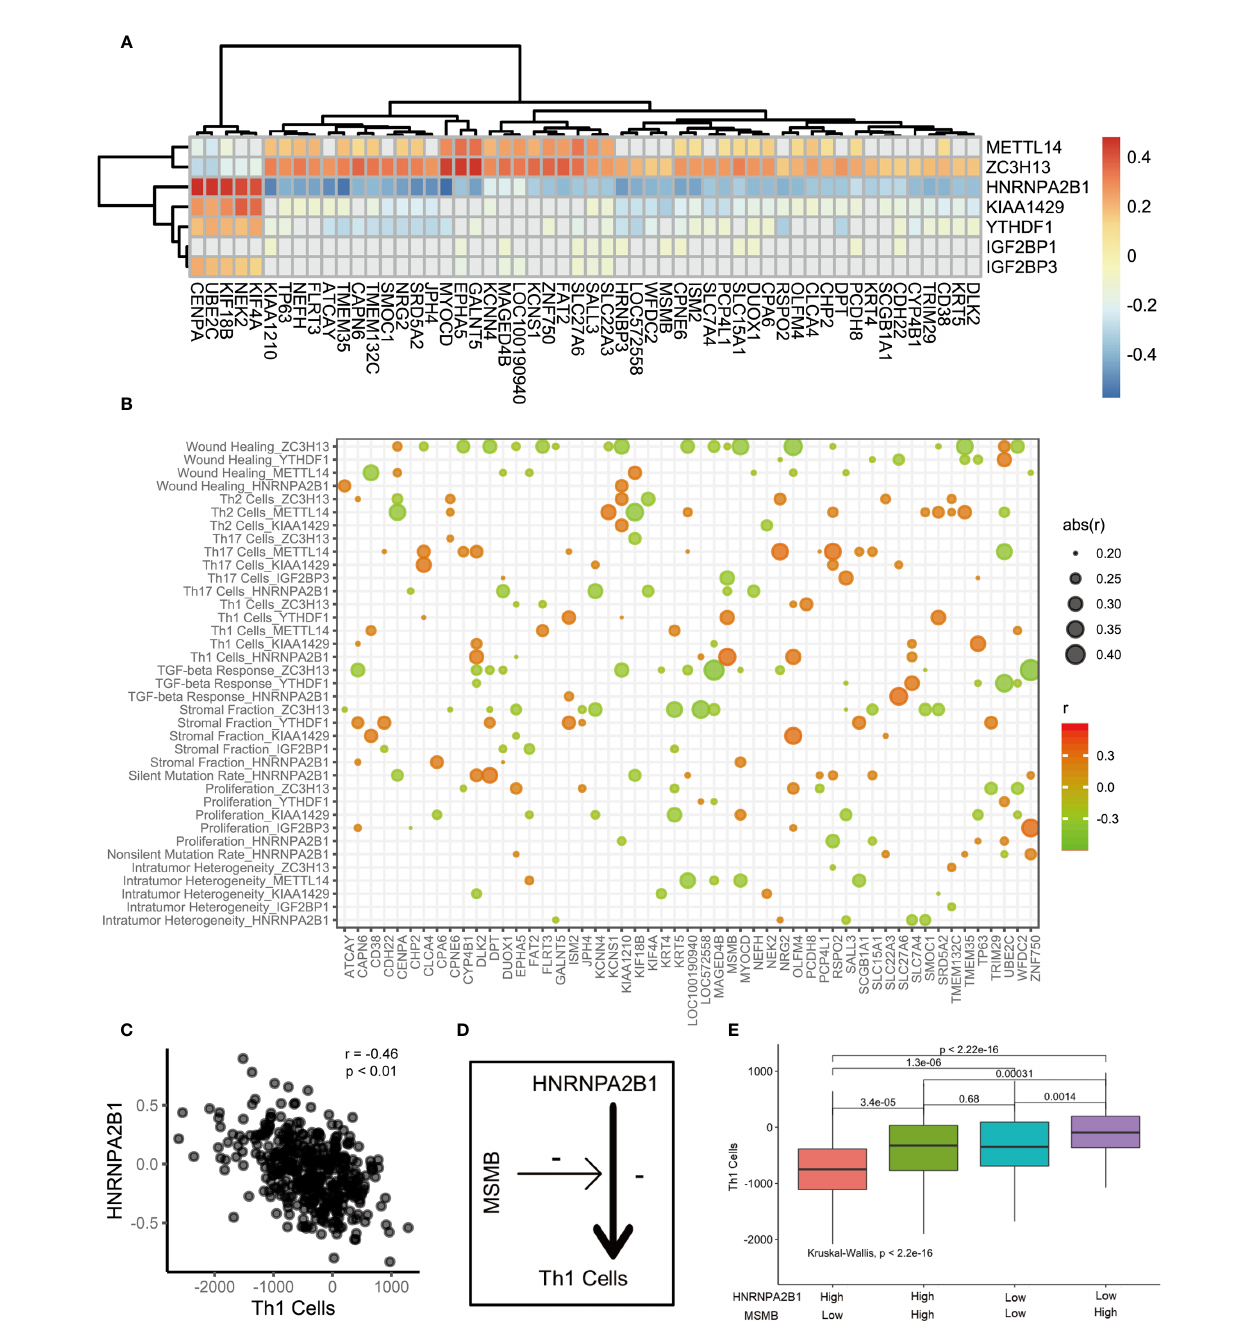
FIGURE 4 | The correlation of m6A regulators, immune cells and m6A associated genes. (A) The heatmap represented the correlation between key m6A regulators and key m6A associated genes. positive correlation was marked with red. negative correlation was marked with green. grey means p>0.05. (B) Bubble shown mean of correlation coef fi cient among m6A regulators, immune cells and m6A associated genes. The text on the left indicated the m6A regulators and immune cells. The text on the low represent m6A associated genes. mean of correlation coef fi cient were marked with size and color of circle. (C) The correlation between Th1 Cells and HNRNPA2B1. (D) The schematic diagram. (E) The median split was used to compare the effects of HNRNPA2B1 and MSMB on Th1 in fi